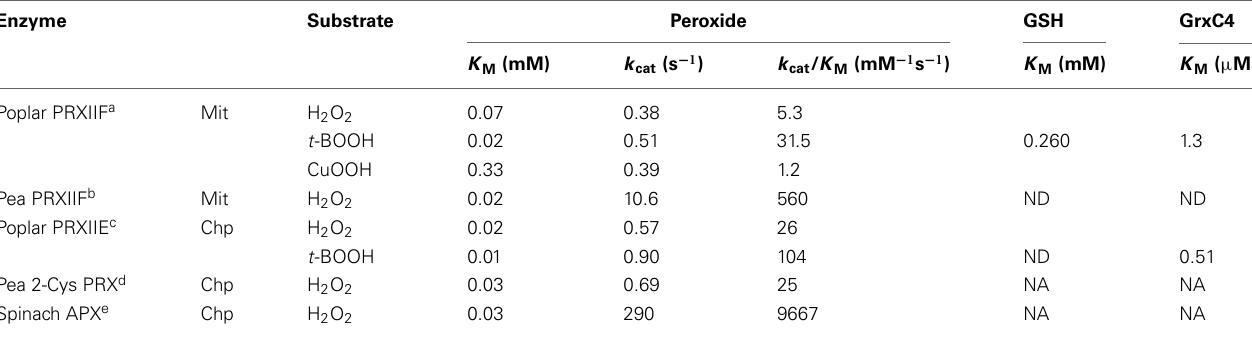
Table 4 | Kinetic chacteristics of glutaredoxin-dependent peroxiredoxins from poplar and pea. Enzyme